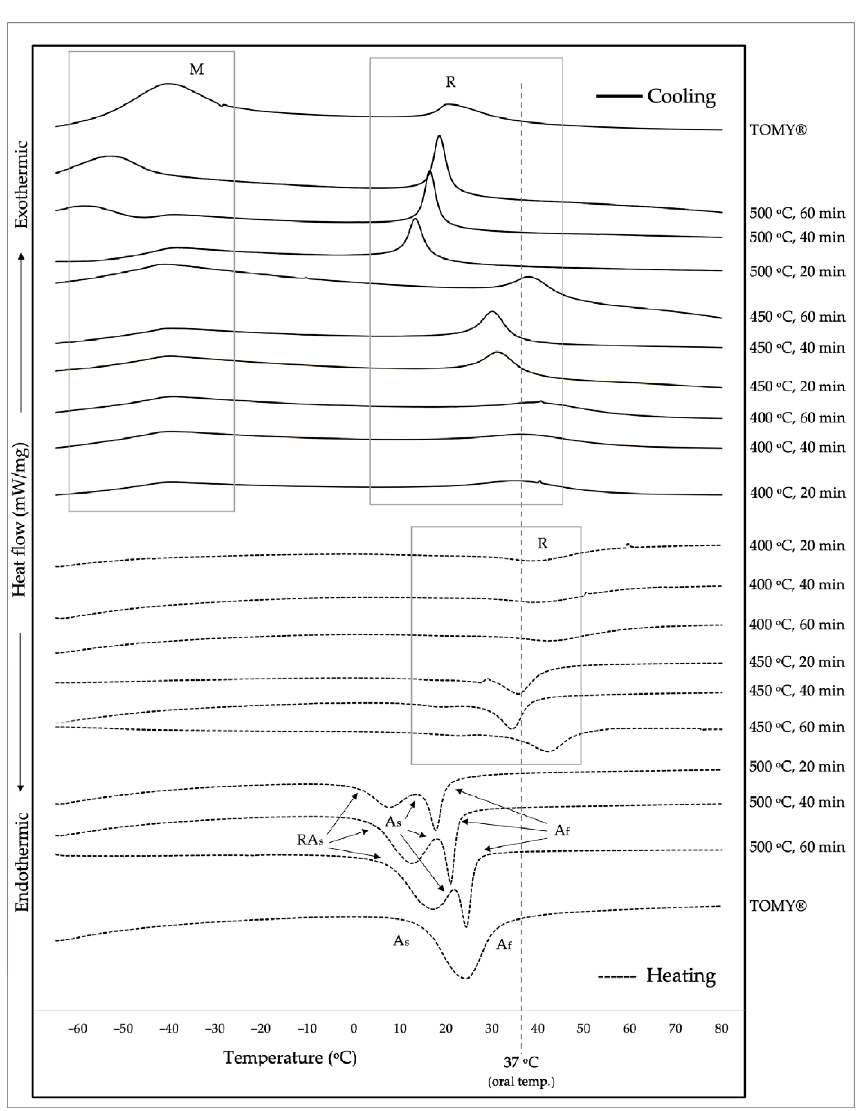
Figure 3. Cooling (as solid lines) and heating (as dash lines) curves of custom-made and commercial NiTi closed coil springs under different temperatures and times of heat treatment (comparable with oral temperature 37 °C); M = Martensitic phase, R = Rhombohedral phase, A s = Austenite start temperature, A f = Austenite finish temperature, RA s = Rhombohedral reverse start temperature. Table 2. The Transformation Temperature Range (TTR) of custom-made and commercial NiTi closed coil springs (TOMY ® ).